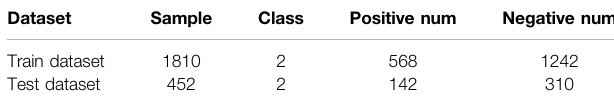
TABLE 1 | Antioxidant protein datasets information.